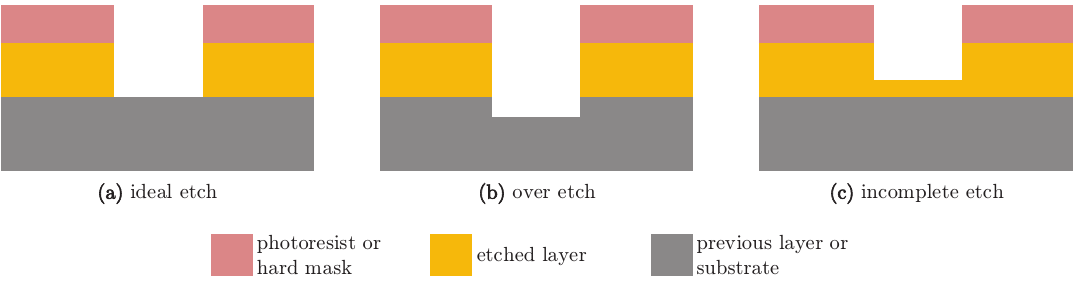
Figure 4. Completion levels of the plasma etching